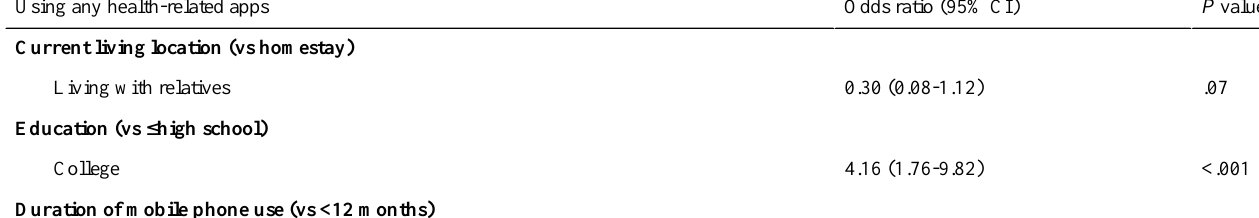
Current living location (vs